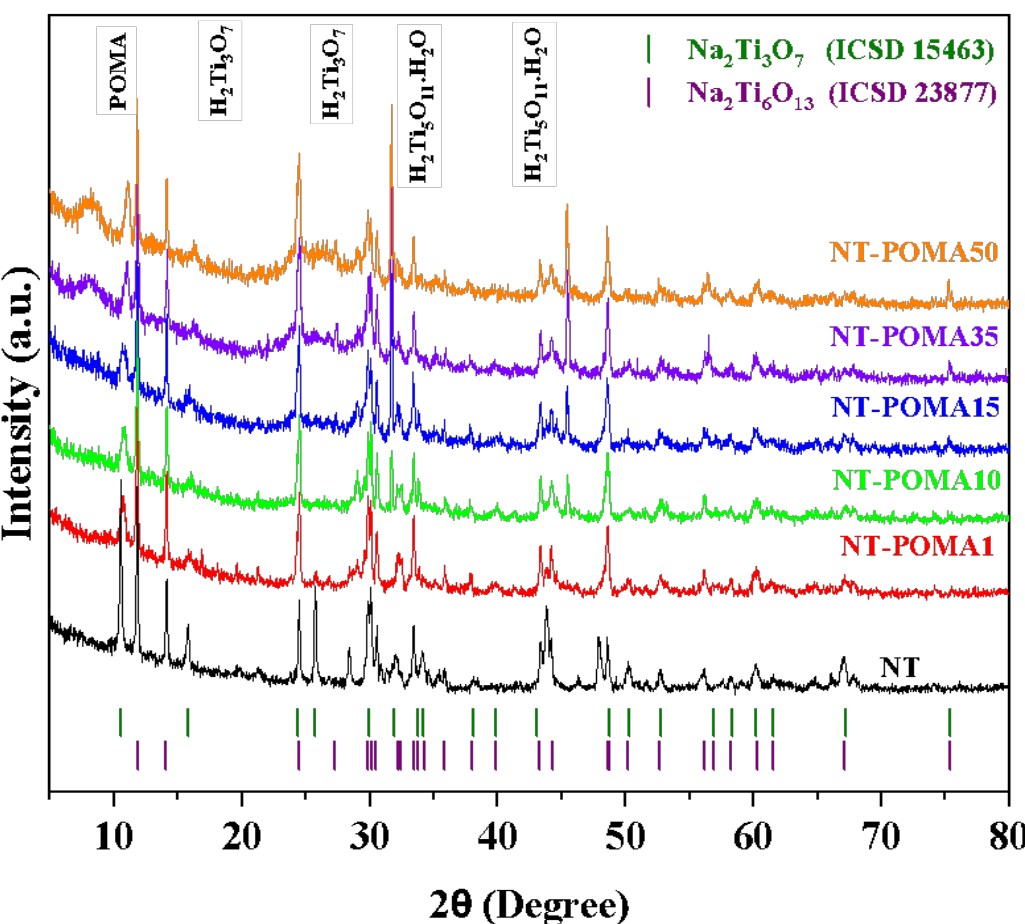
Figure 1. Diffraction patterns for NT, NT-POMA1, NT-POMA10, NT-POMA15, NT-POMA35 and NT-POMA50. The vertical lines indicate the Bragg peaks of Na 2 Ti 6 O 13 and NaTi 3 O 7 from the ICSD cards n° 23,877 and 15,463, respectively. The labels NT, NT-POMA1, NT-POMA10, NT-POMA15, NT-POMA35 and NT-POMA50 correspond to 0.0%, 0.1%, 10%, 15%, 35% and 50% of POMA content, respectively.